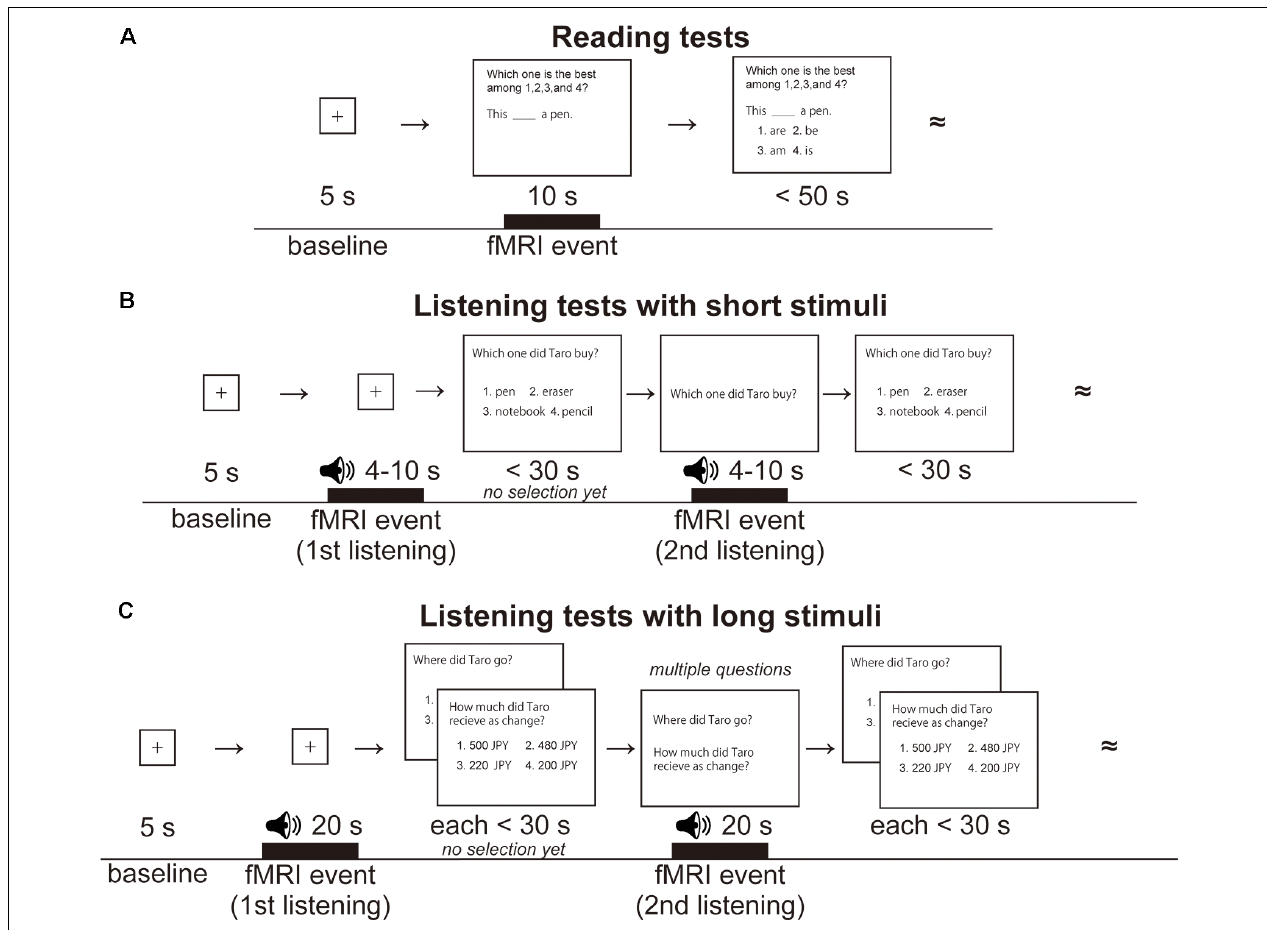
FIGURE 1 | Examples of reading and listening tests for learning Japanese as a second language. (A) A single trial of the reading tests. Following the presentation of a fixation point for 5 s (baseline for brain activation), a test sentence was visually presented for 10 s (an fMRI event of reading ), and then four choices were additionally presented as possible replacements for the underlined portion of the sentence. The participants were required to select one of the choices within 50 s. The double tilde symbols denote continuation of similar trials in that run. Visual stimuli were presented in Japanese, but English equivalents are shown here. (B) A single trial of the listening tests with short stimuli. The same speech stimulus was presented twice, for 4–10 s each time (fMRI events labeled first listening and second listening ). After listening to the first stimulus, the participants were visually presented with a question sentence and four possible answers and were given 30 s to proceed without choosing an answer. After listening to the second stimulus, the participants finally chose one of the four answers by pressing a button. Both auditory and visual stimuli were presented in Japanese, but English equivalents are shown here. (C) A single trial of the listening tests with long stimuli. The same speech stimulus was presented twice, for 20 s each time (fMRI events labeled first listening and second listening ), together with multiple questions. English equivalents are shown